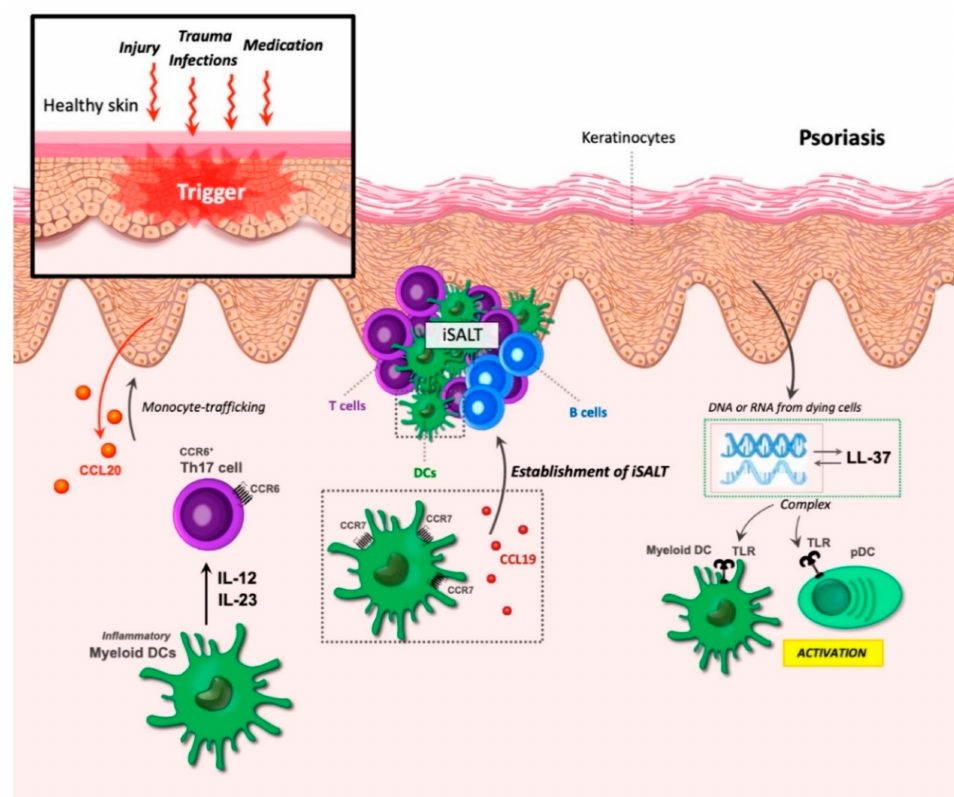
Figure 6. Dendritic cells (DCs) in psoriasis. Psoriasis can be triggered by various factors, including trauma, infections, injury, and medication. The increased proliferation of keratinocytes leads to thickening of the epidermis, while the corneocytes fail to stack normally. During epidermal injury, keratinocytes secrete CCL20, leading to the recruitment of CCR6 + monocytes that, together with dermal DCs, are critical for psoriasis development. Inflammatory myeloid DCs produce the cytokines IL-12 and IL-23, resulting in the activation and expansion of Th17 cells and leading to an autoimmune response. The formation of inducible skin-associated lymphoid tissue (iSALT) structures occurs in psoriatic lesions. CCR7 and CCL19 partake in the establishment of these structures. iSALT primary contains CD3 + T cells, CD11c + LAMP3/DC-LAMP + DC, and, to a minor extent, CXCR5 + B cells. Keratinocytes produce the antimicrobial peptide LL-37, which can form complexes with DNA and RNA from dying cells. These complexes bind to toll-like receptors (TLRs) in myeloid DCs and pDCs leading to the activation of these